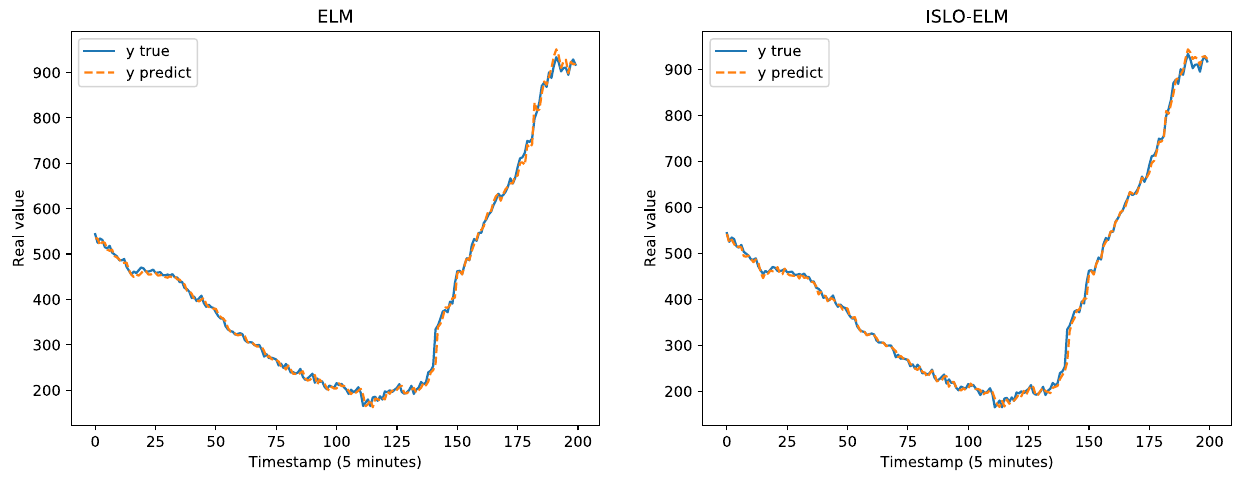
Fig. 11 Prediction results of ELM and our ISLO-ELM model on the EU Internet traffic